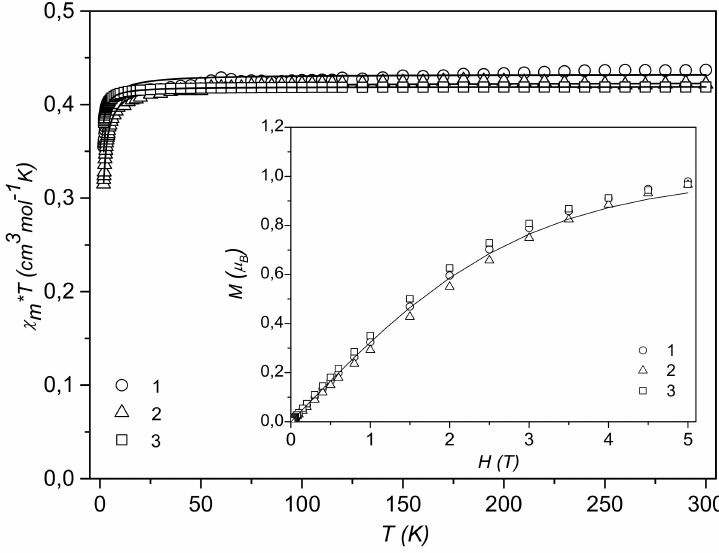
Figure 4. Temperature dependences of experimental χ m T vs. T ( χ m per one Cu II atom) for 1–3. The solid lines are the calculated curves derived from Equations (1) and (2). The inset shows field dependences of the magnetization ( M per one Cu II atom) at 2 K for 1–3 . The solid line is the Brillouin function curve for one uncoupled spin with S = 1 / 2 and g =